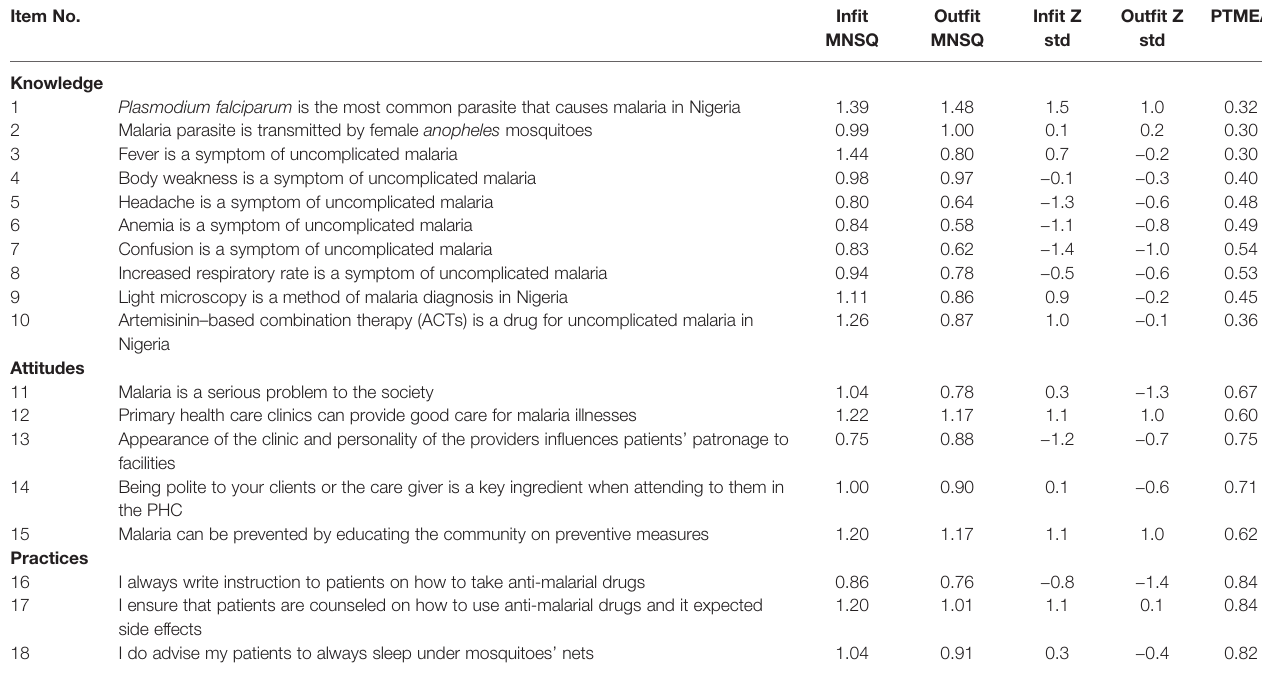
TABLE 5 | Items fi t and mis fi t indices for healthcare workers ’ knowledge, attitudes, and practicesinstrument for uncomplicated malaria-18 items (N = 121). Item